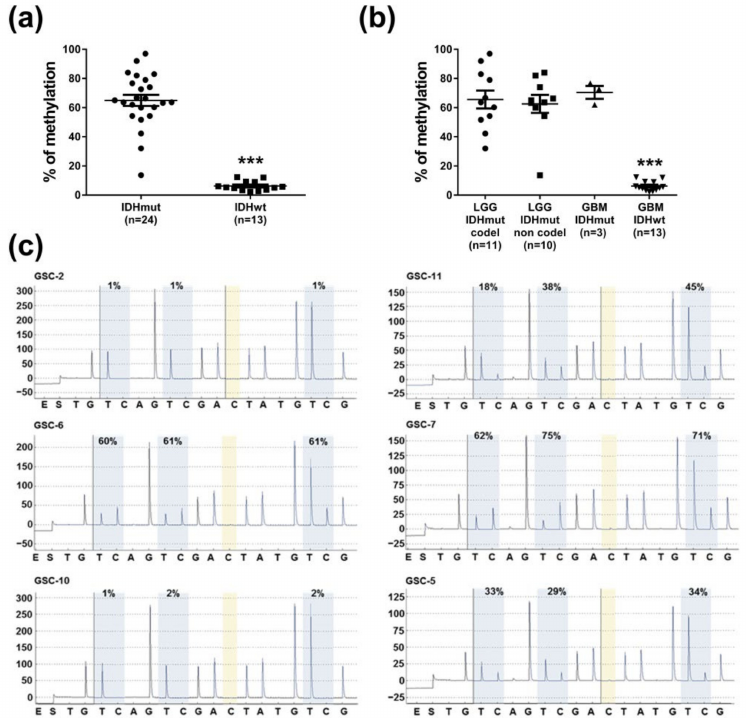
Figure 2. Methylation status of MEOX2 promoter. ( a ) Average percentage of methylation according to IDH1 mutational status; ( b ) Average percentage of methylation for each molecular subtype of glioma ( n = 37), according to the 2016 WHO classification; *** p < 0.001, Kruskal–Wallis test; ( c ) Promoter methylation profile of three CpG sites in MEOX2-expressing (2, 6, 10) and non-expressing GSC (11, 7, 5).